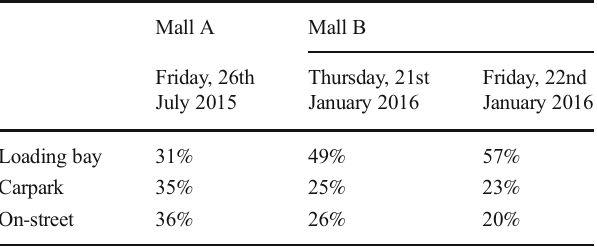
Percentages of vehicles parking inside the loading bay, the carpark and on-street Mall